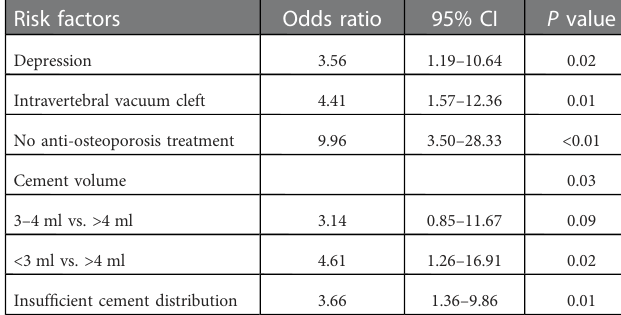
TABLE 3 Multivariate logistic regression analysis of independent risk factors for residual low back